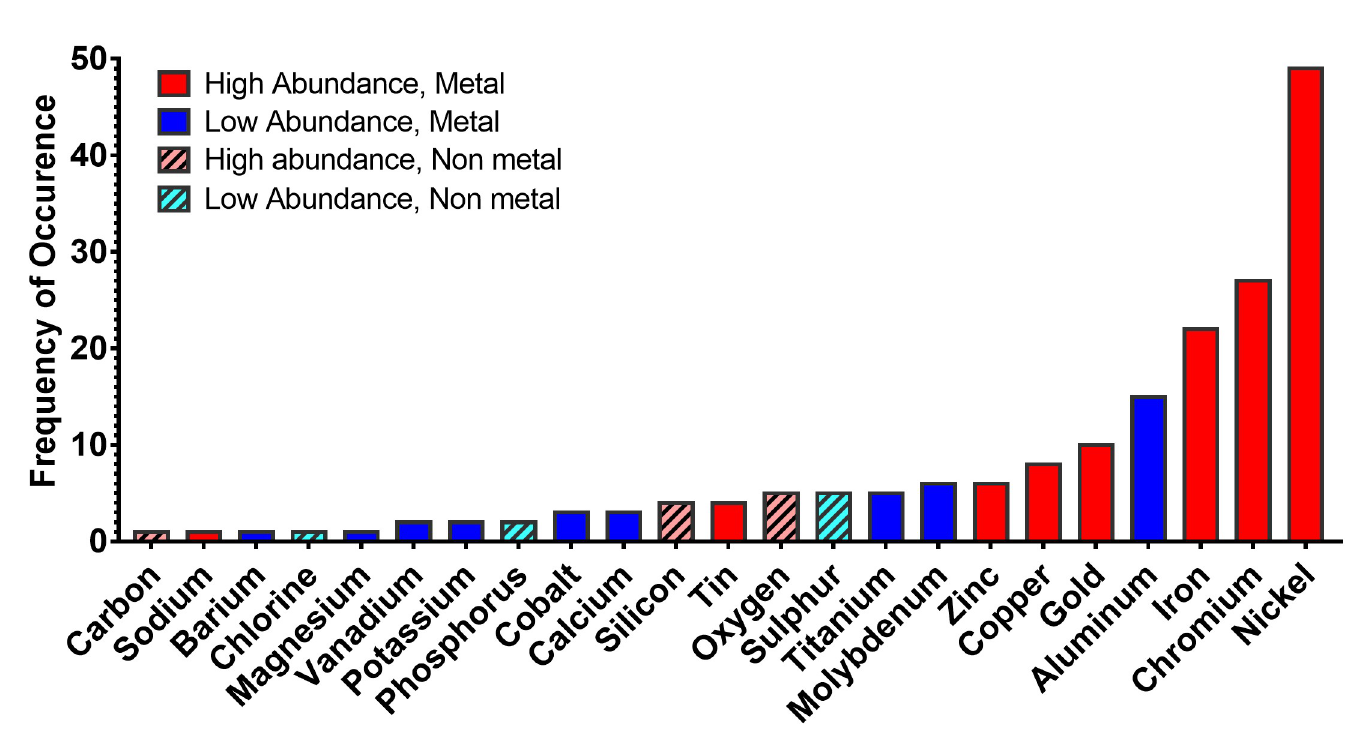
Fig 7. Frequency of occurrence of elements in pod EC atomizers. The x-axis shows metal/elements sorted according to increasing frequency of their occurrence (1–49), with nickel being the highest. Bars are coded based on each element’s relative abundance. Solid bars are metals, while hatched bars are non-metals. Red bars = metals in major abundance, blue bars = metals in minor abundance, red hatched bars = non-metals in major abundance, hatched blue bars = non-metals in minor abundance.